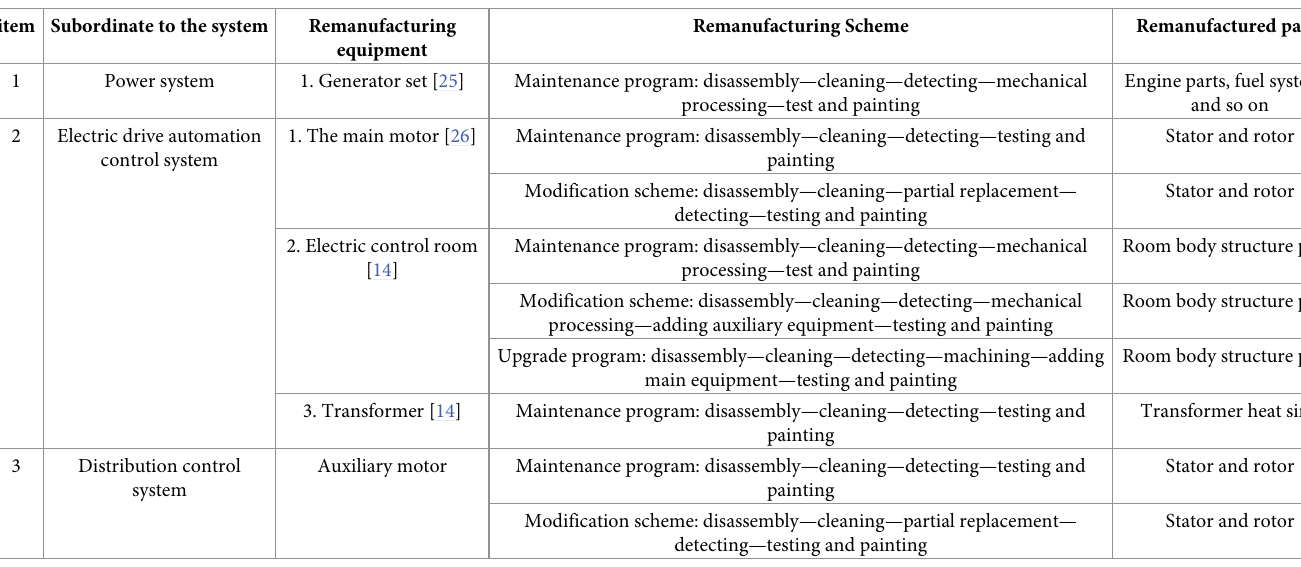
Table 1. Typical remanufacturing